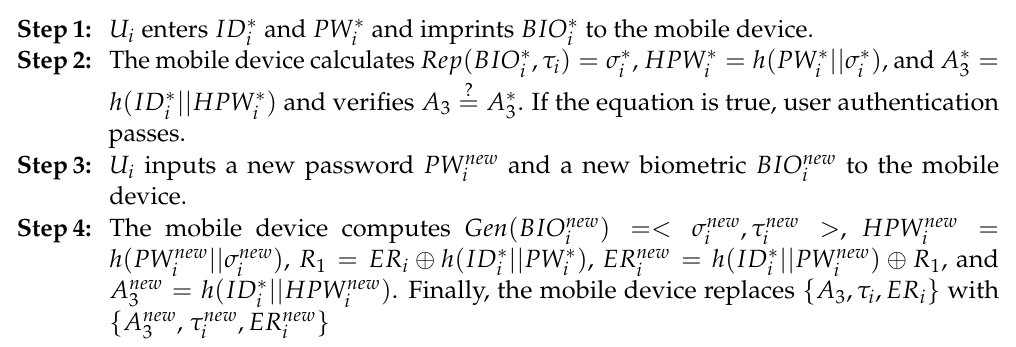
Figure 8. Password update phase of the proposed